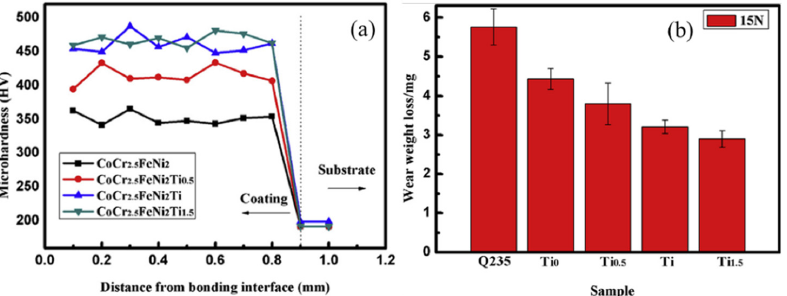
Figure 9. ( a ) The micro-hardness of CoCr 2.5 FeNi 2 Ti x (x = 0, 0.5, 1, 1.5) HEA coatings, and ( b ) the wear loss of the worn samples [80].